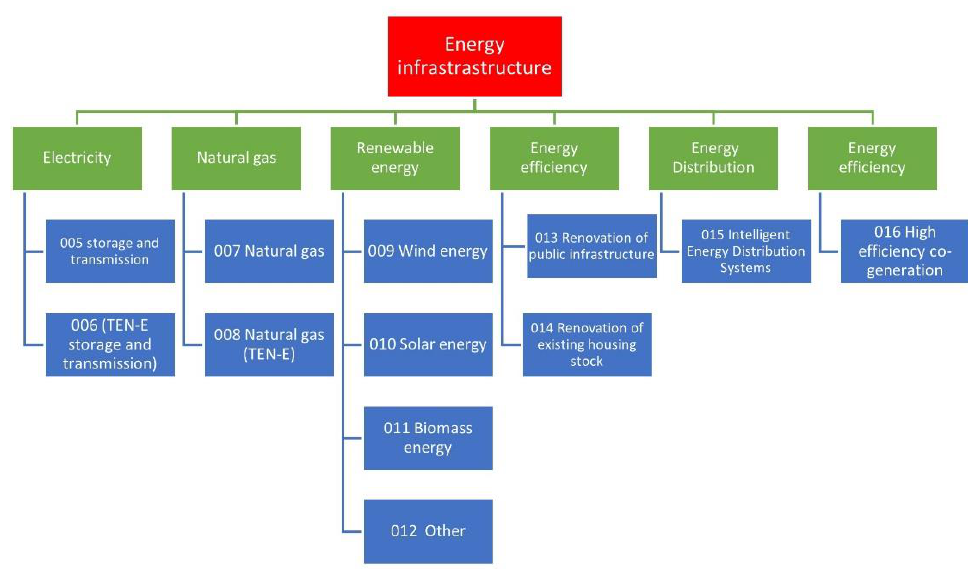
Figure 14. Interventions related to energy in ETC programmes in the period 2014–2020 under the Energy Infrastructure strand. Source: own study based on [52].